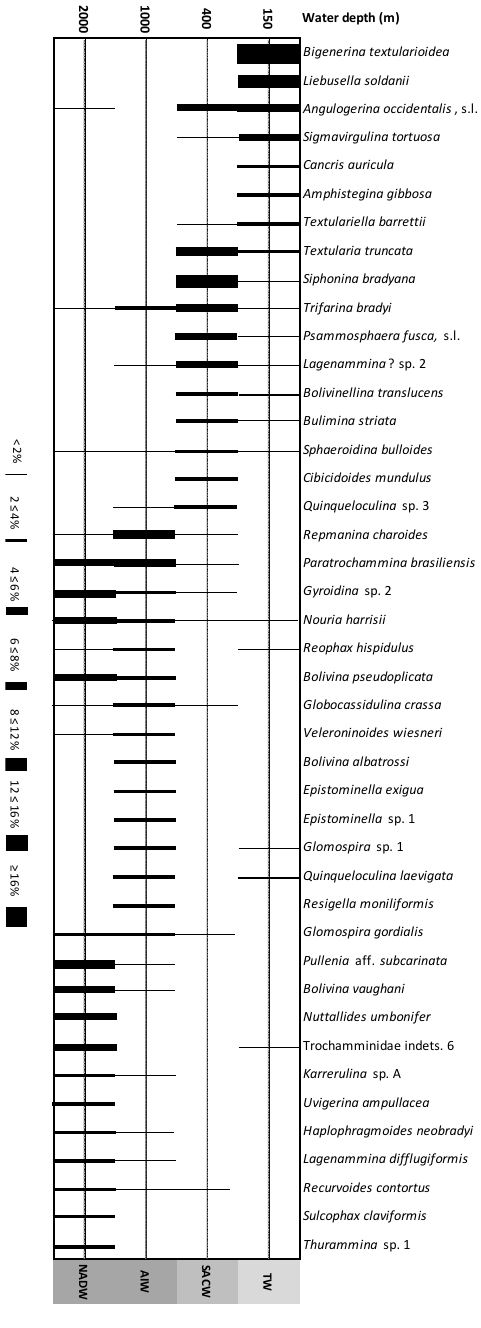
Figure 9. Species and their respective relative frequencies at the subsurface layer. When layers are integrated, the species with relative frequency >4% at 150 m are Bigenerina textularioidea , Angulogerina occidentalis , s.l., and Sigmavirgulina tortuosa , but also